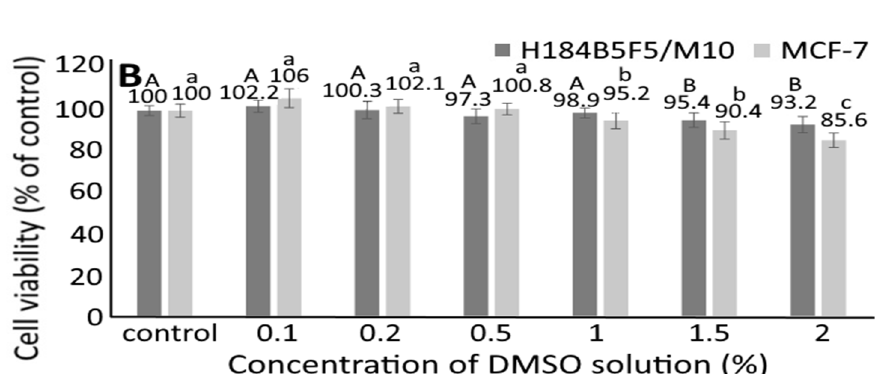
Figure 4. Effect of blank nanoemulsion ( A ) and DMSO solution ( B ) on growth of human breast MCF-7 cancer cells and mammary H184B5F5/M10 cells. Results are presented as mean ± standard deviation of triplicate independent experiments. Data with different capital letters (A,B) for H184B5F5/M10 cells and small letters (a–d) for MCF-7 cancer cells are significantly different at p < 0.05.